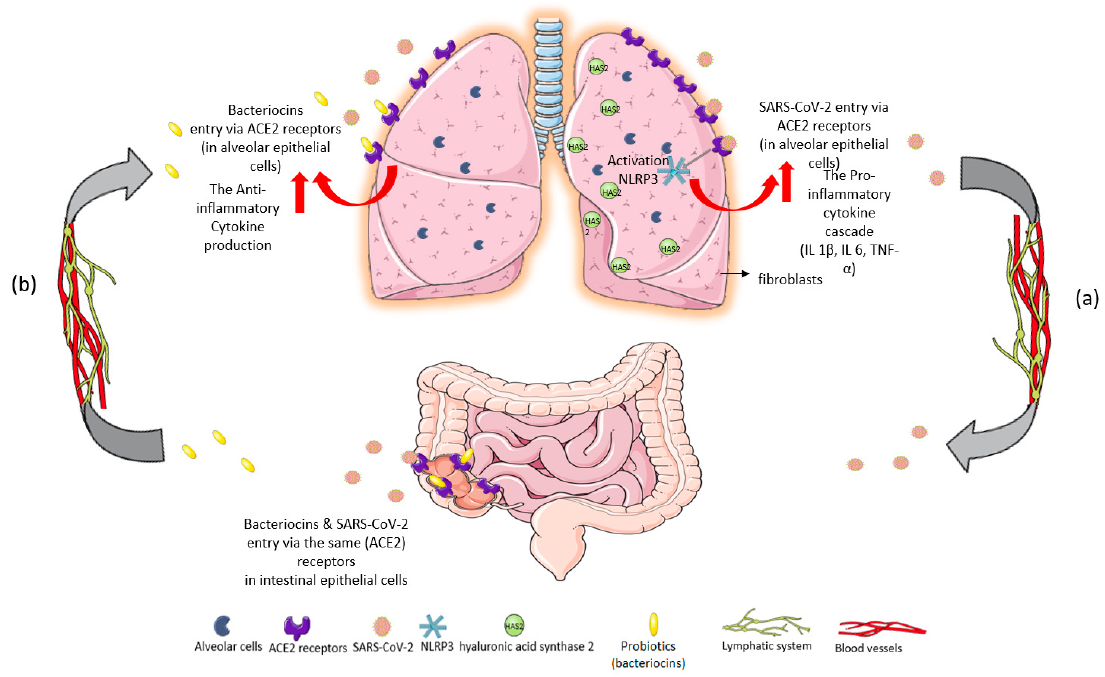
Figure 1. Immunomodulatory response of gut–lung axis cross-talk after: ( a ) SARS-CoV-2 invasion and ( b ) probiotic intake of L. plantarum . ( a ) SARS-CoV-2 binds to ACE2 receptors in the epithelial cells of the lungs. The massive cytokine release after viral entry leads to NOD-, LRR-, and pyrin domain-containing protein 3 (NLRP3) inflammasome overactivation, exacerbating the inflammatory cascade [9]. High levels of proinflammatory cytokines IL-1 β , IL-6, and TNF- α are inducers of hyaluronic acid synthase 2 (HAS2) in the endothelium, alveolar epithelial cells, and fibroblasts. Hyperinflammation leads to hyaluronic acid production and accumulation in the alveoli of patients with severe COVID-19. The development of pulmonary fibrosis occurs due to inflammatory response and severe infection. The virus infects intestinal epithelial cells in the same way that it directly attacks alveolar epithelial cells. ( b ) Probiotics could restrict SARS-CoV-2 invasion and proliferation through their metabolites, bacteriocins (antimicrobial peptides), because of their ability to block ACE2 receptors [9]. Specifically, L. plantarum bacteriocins compete with the virus for the same host sites [10]. Thus, probiotics could offer a protective effect against acute respiratory distress syndrome (ARDS) in COVID-19 infection, reverse the “cytokine storm”, and reduce hyaluronic acid synthesis in the lungs